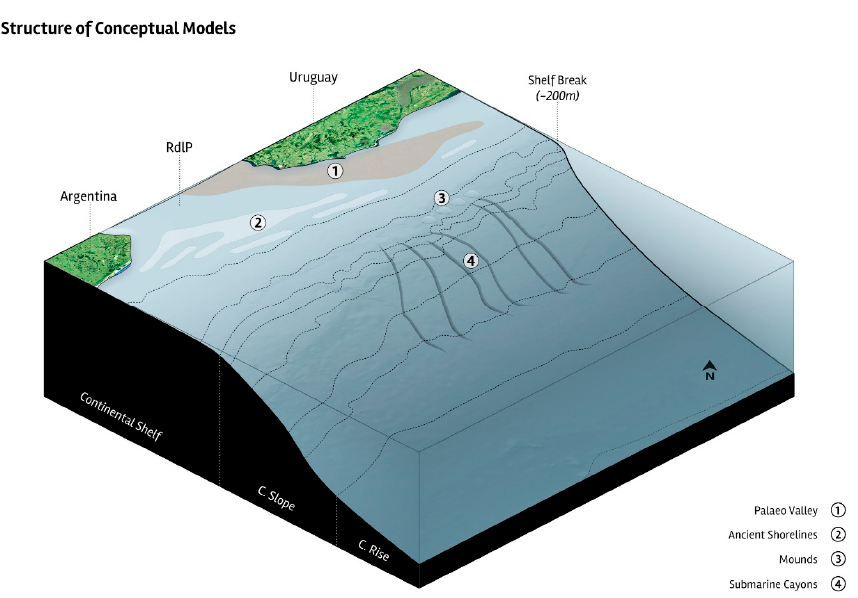
Figure 1. Map showing the location of the study area; the Territorial Sea and the Economic Exclusive Zone are indicated ( A ); schematic representation of the regional circulation of the Southwestern Atlantic continental shelf and slope, redrawn from Matano et al. (2010); ( B ) Subantarctic Shelf Water (SASW), Subtropical Shelf Front (STSF), Brazil–Malvinas Confluence (BMC). The transitional character and complex hydrodynamics of the UCM are also imprinted on the seafloor and include the northernmost distribution of an enormous contouritic depositional system (CDS; depositional, erosional, and mixed features formed by bottom currents). The CDS in the UCM was delineated by the continuous action of Antarctic water masses along the Pleistocene. It also presents the RdlP Pleistocene drain imprint (paleovalley and mud belts [20–24] (Figures 1A and 2).